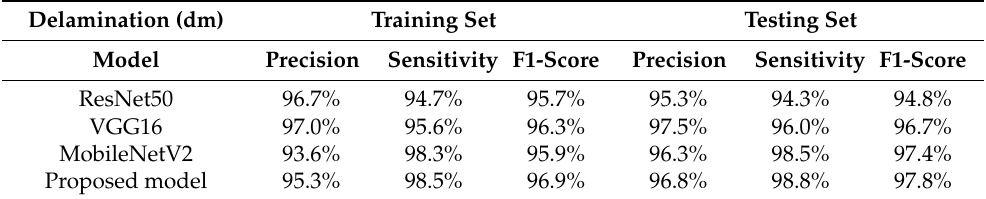
Table 7. Overall precision, sensitivity, and F1-Score of the delamination concrete. Delamination (dm) Training Set Testing Set